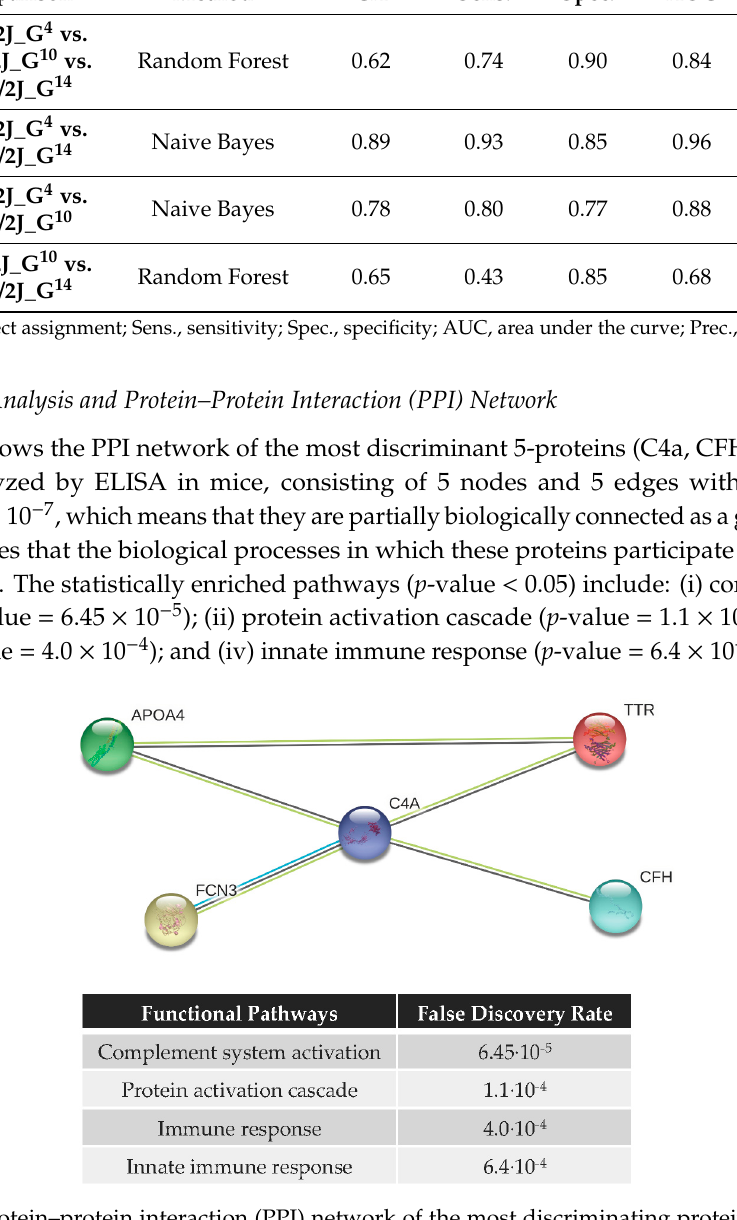
Figure 5. Protein–protein interaction (PPI) network of the most discriminating proteins (C4a, CFH, APOA4, TTR, and FCN3, after SPSS analysis) obtained by String software, containing 5 nodes (proteins) and 5 edges, with PPI enrichment p -value = 2.68 × 10 − 7 .